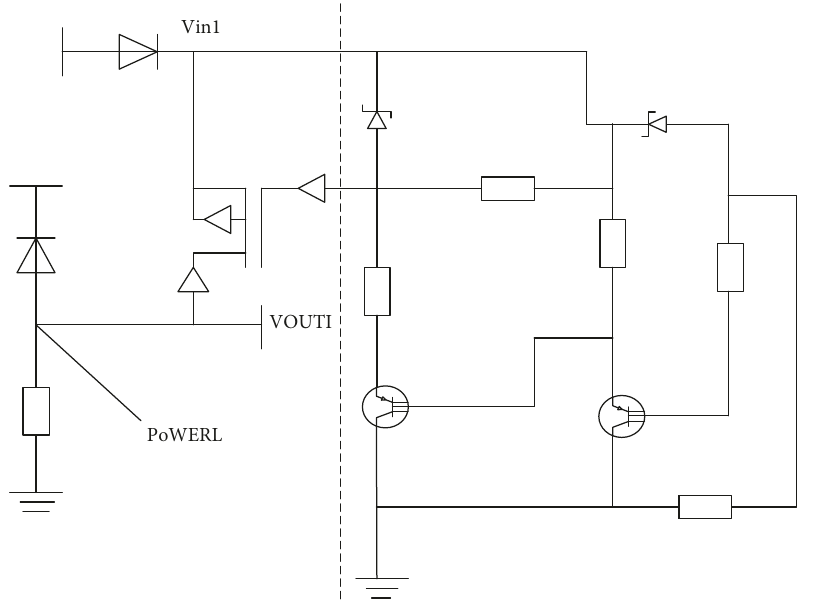
Figure 5: Preprotection circuit of the power